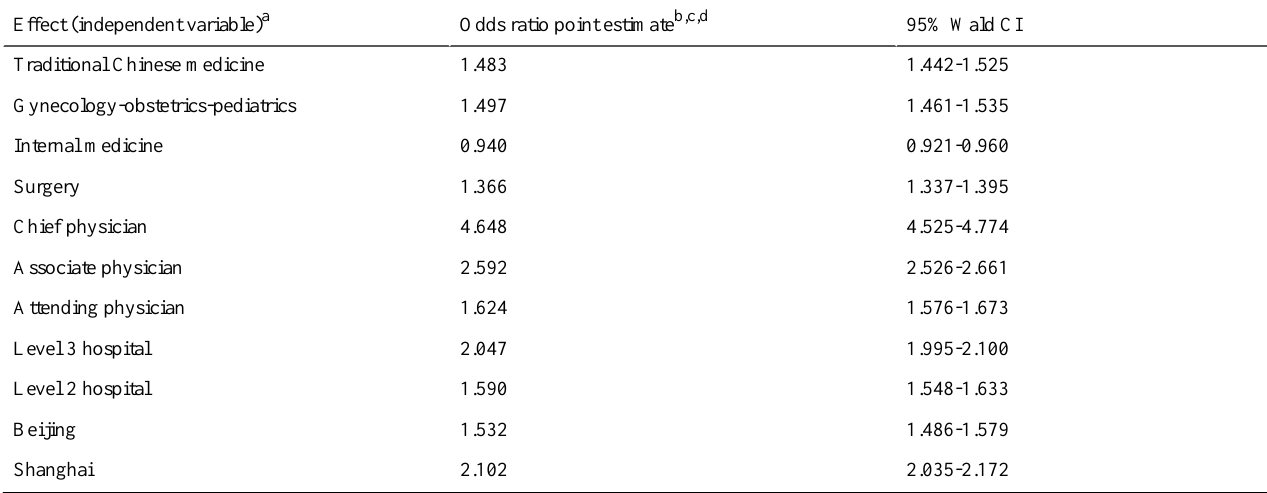
Table 3. Results from the binary logistic regression